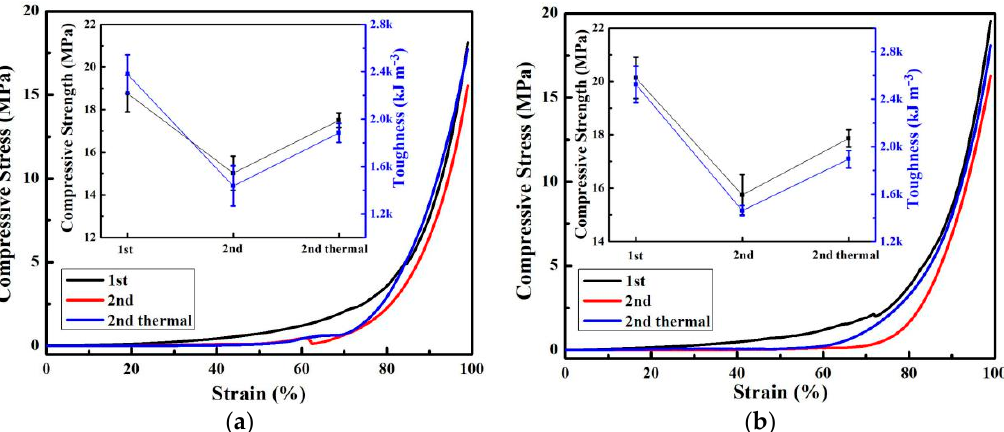
Figure 5. Thermal recovery of the compressive properties of ( a ) PDN hydrogels and ( b ) GDN hydrogels.